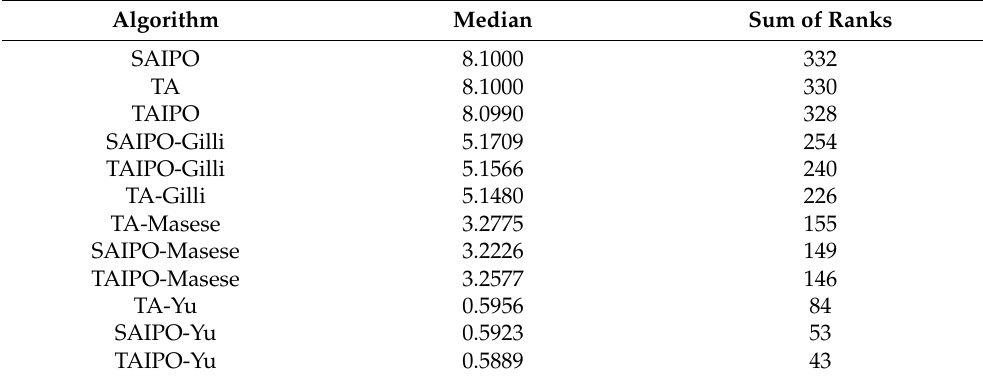
Table 7. Friedman Test TA, TAIPO and SAIPO Algorithms with MARR